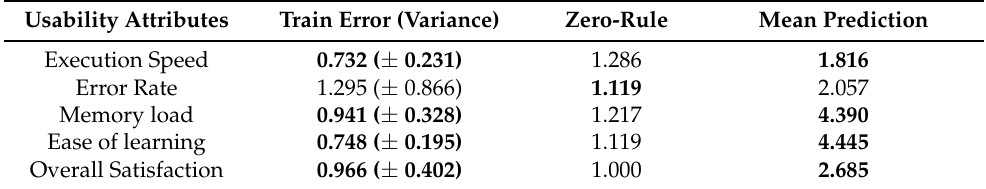
Table 4. Obtained